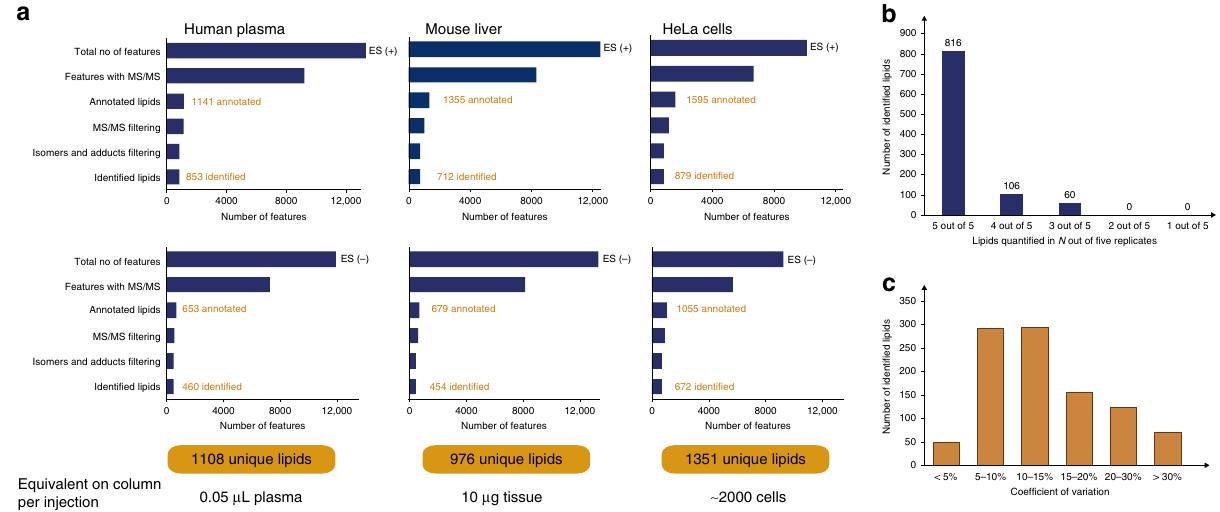
Fig. 3 Lipid identi fi cation and quanti fi cation. a Sequential data analysis steps from the total number of detected 4D features to unique lipids for human plasma, mouse liver, and human cancer cells in both ionization modes. b Number of lipids quanti fi ed in N out of fi ve replicate injections of liver tissue extract. c Coef fi cients of variation for 976 lipids quanti fi ed in at least three out of fi ve replicate injections of liver tissue